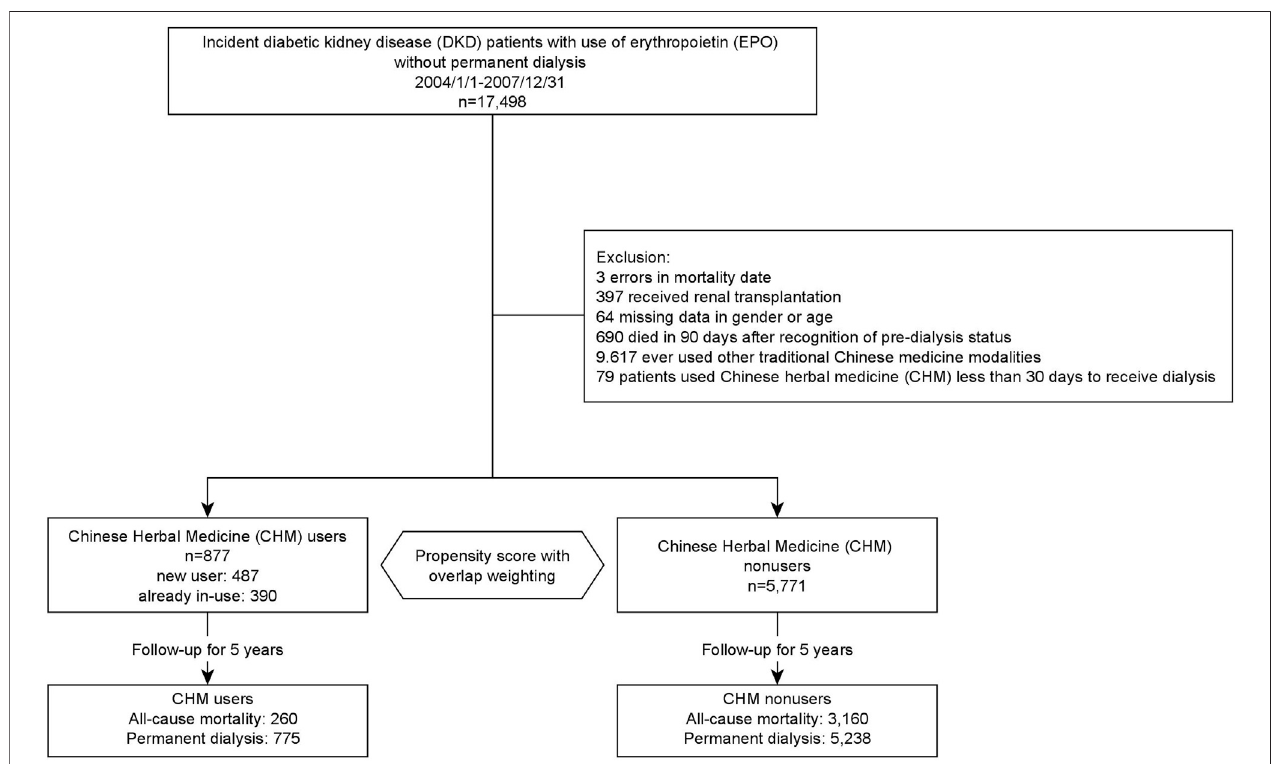
FIGURE 1 | Flow diagram of this